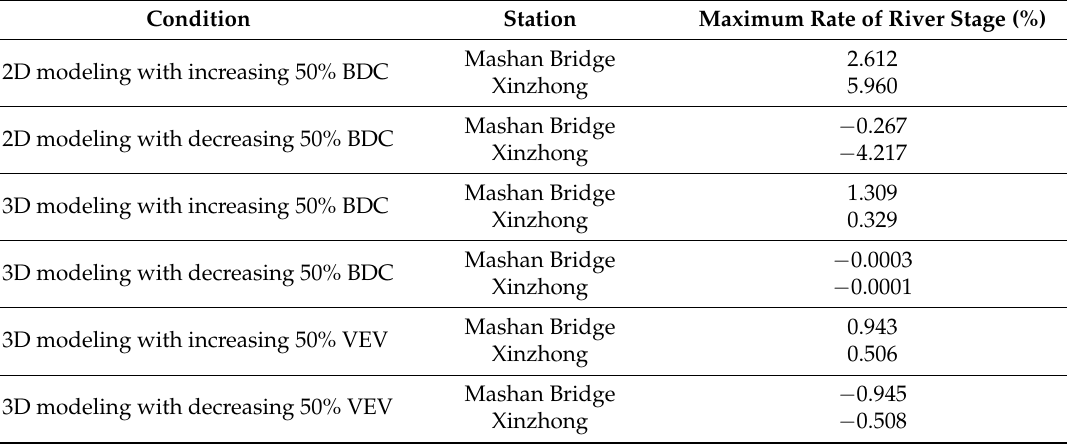
Table 4. The influence of model sensitivity runs on river stage under high flow